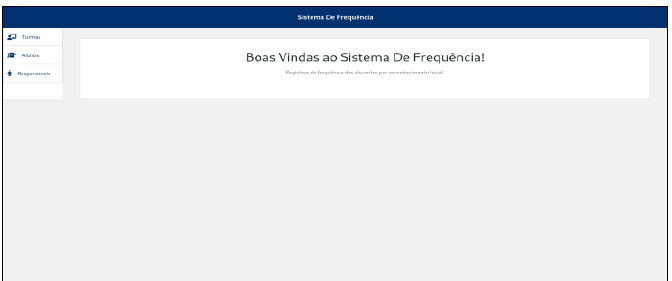
Figure 6: System Home Page.